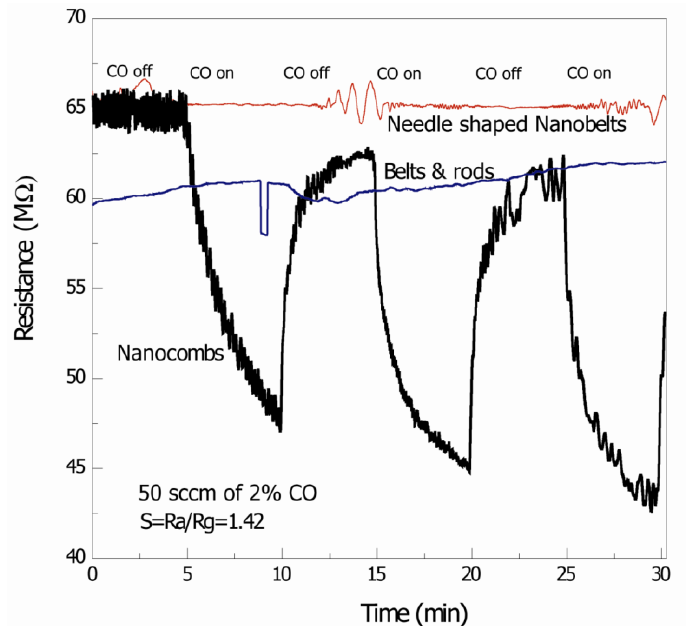
Figure 4. Sensing results for 2% CO gas at 75 °C suggest that only comb-like structures show cyclic changed in resistance with on and off cycles of CO